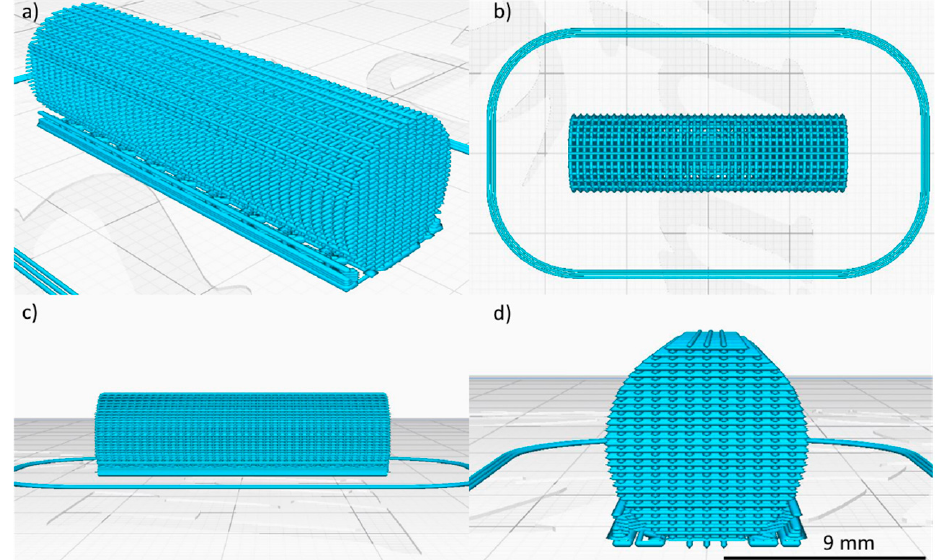
Figure 1. Three-dimensional-printed scaffolds . ( a ) Isometric view; ( b ) top view; ( c ) lateral view; and ( d ) front view.